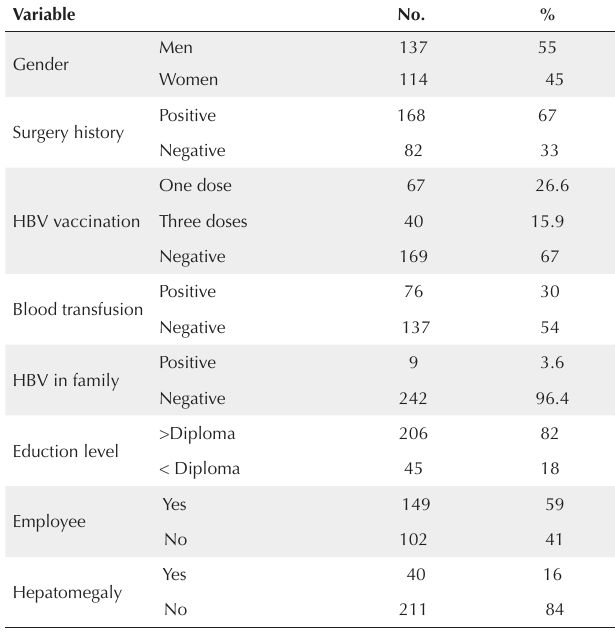
Table 1. Demographic Data of Patients